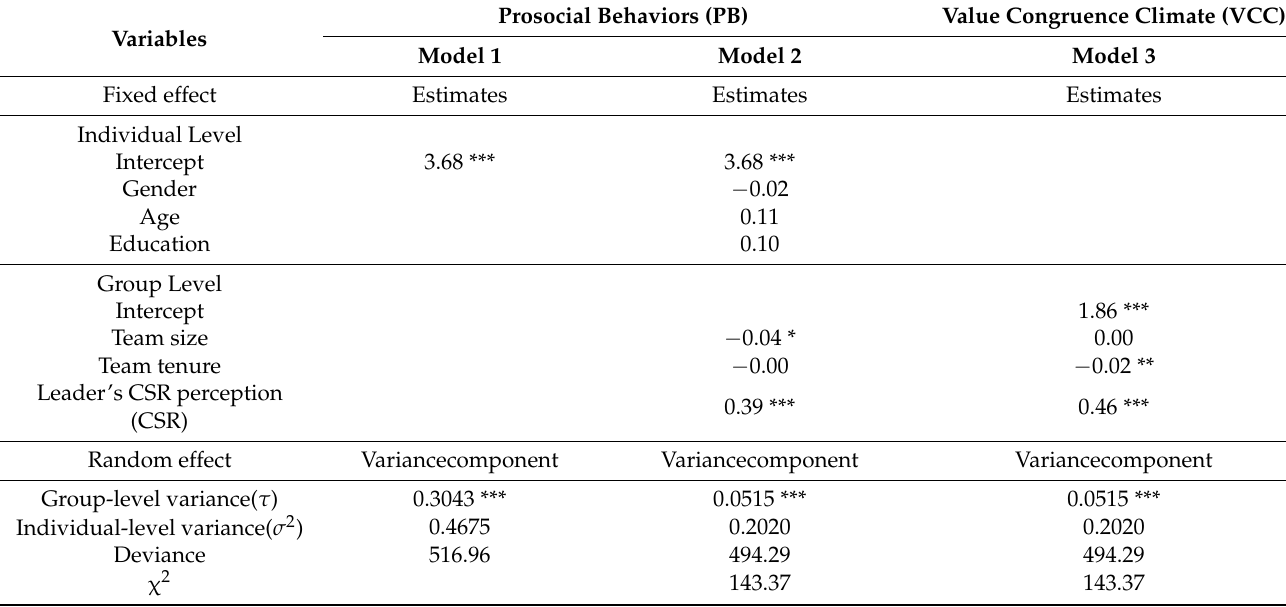
Table 2. Hierarchical linear model predicting: Direct